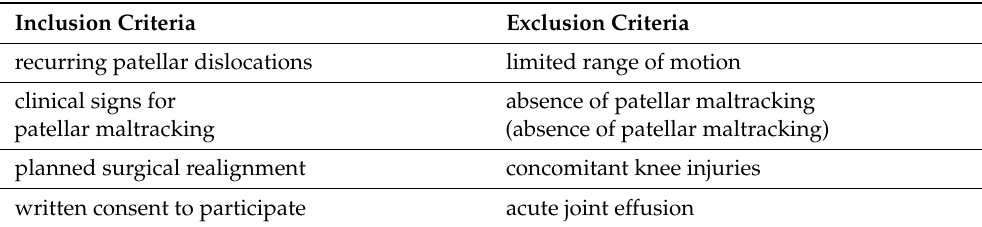
Figure 2. Lateral patellar maltracking in a left knee. Preoperative analysis revealed a TT-TG (tibial tubercle to trochlear groove) distance of 18 mm, with no further risk factors ( A ). Intraoperative arthroscopy (with low water pressure) confirmed a lateralized patellar tracking ( B ), reinforcing the indication to perform a medializing osteotomy of the tibial tubercle ( C , D ). A comparison of pre- and postoperative tangential radiographs of the patella showed a successful realignment of the patella ( E , F ). Table 1. Inclusion and exclusion